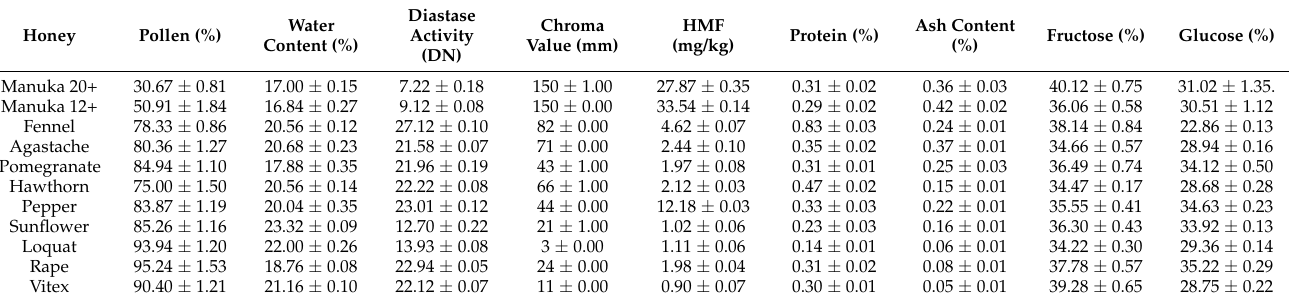
Table 2. Values of physicochemical parameters of the different varieties of honey.